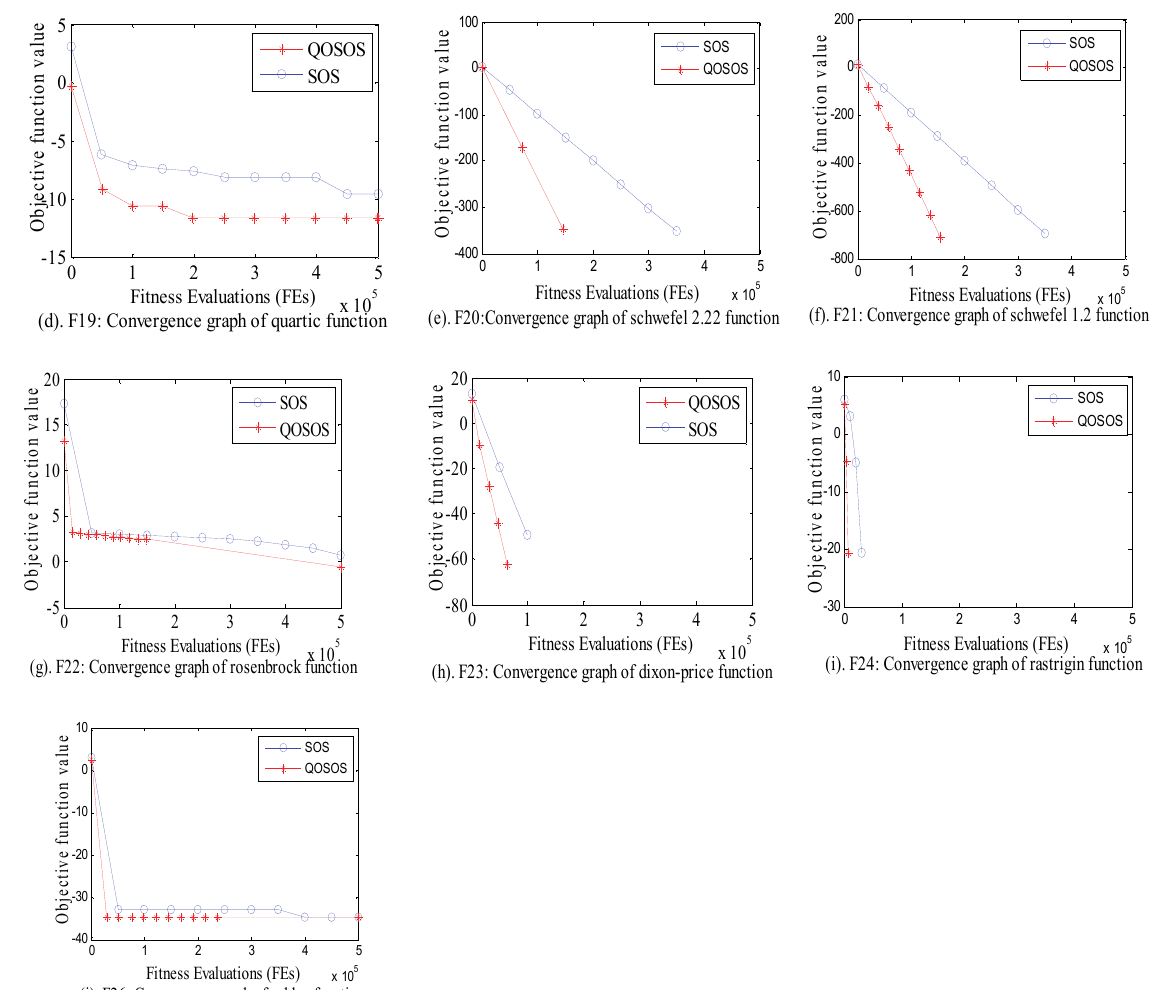
Fig. 2. Convergence graph of ten unconstrained functions which are given in Appendix 1 ((a) F16, (b) F17, (c) F18, (d) F19, (e) F20, (f) F21, (g) F22, (h) F23, (i) F24 and (j)